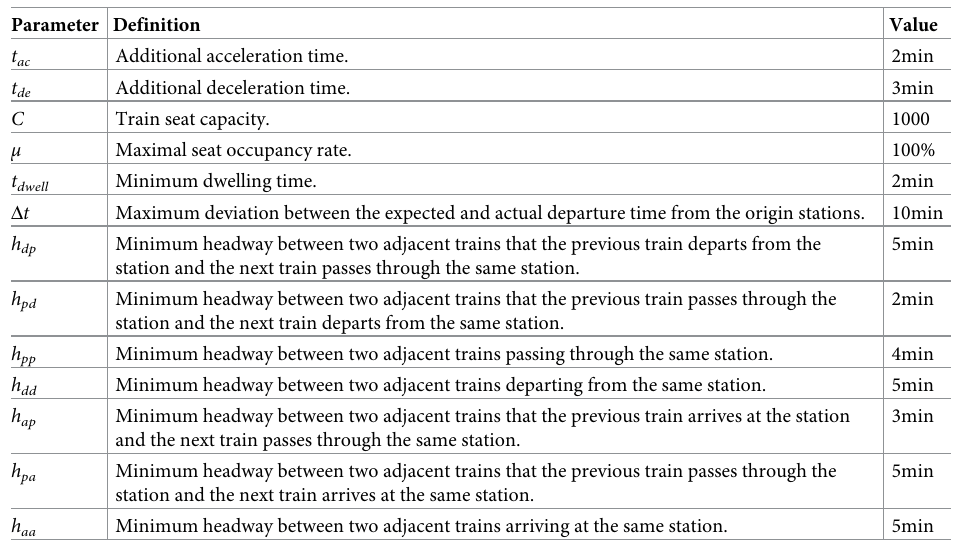
Table 8. Other parameters in